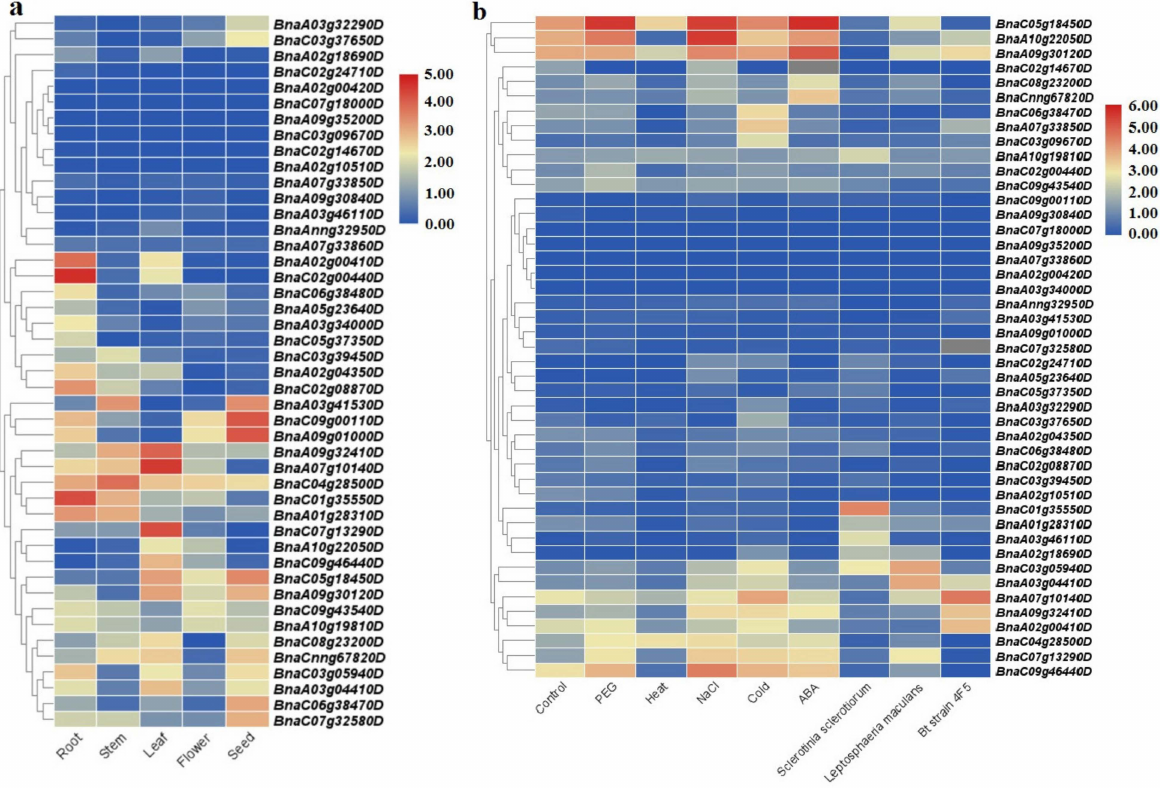
Figure 8. The expression levels of the SULTRs in B. napus , based on the available RNA-seq data: ( a ) in different tissues; ( b ) in response to abiotic and biotic